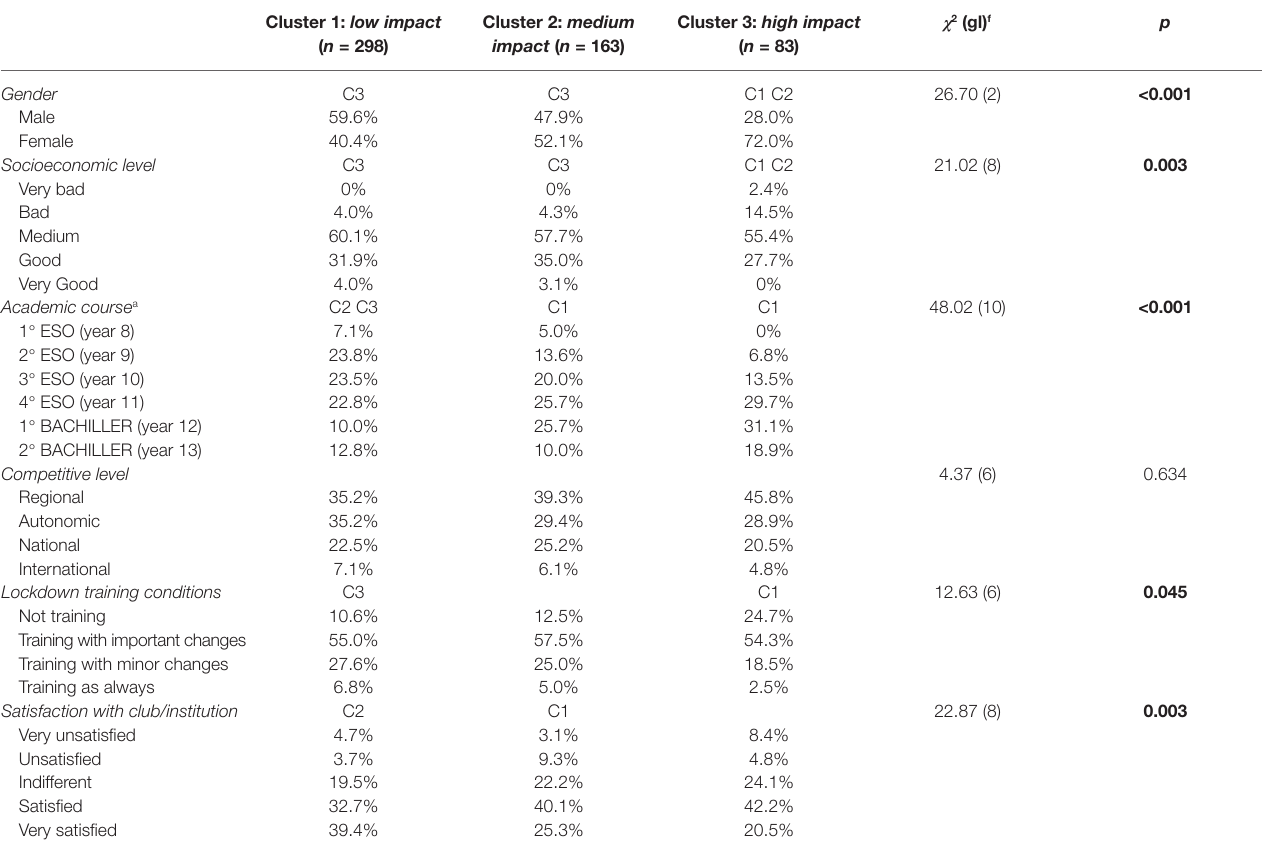
TABLE 3A | Differences in demographic and sports information between clusters (ordinal